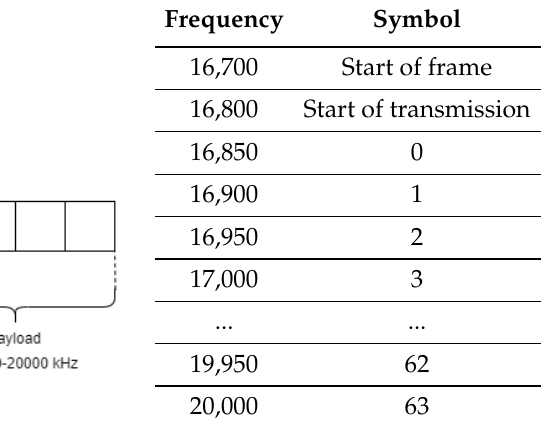
Figure 6. Frame structure ( left ) and symbol encoding as a tone ( right